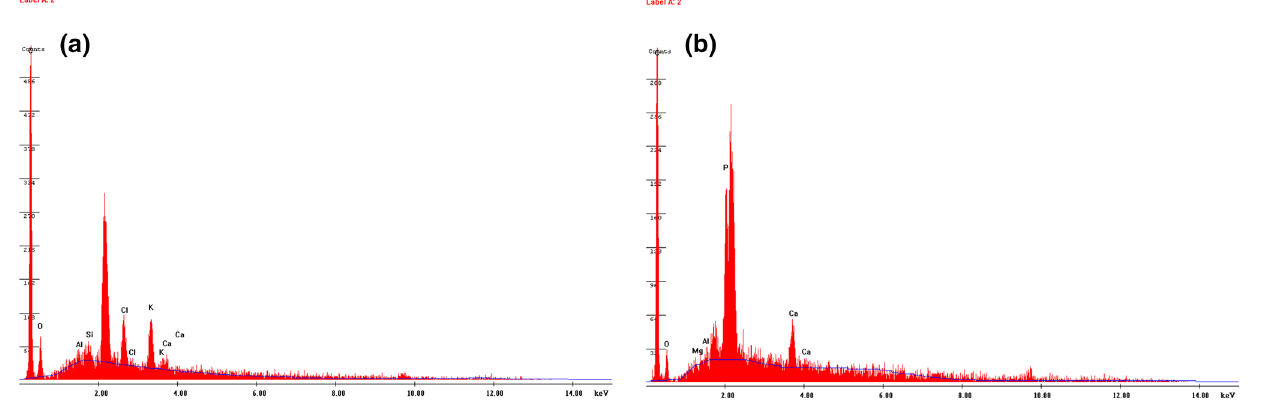
Fig. 3 EDX spectrum of a CHR and b